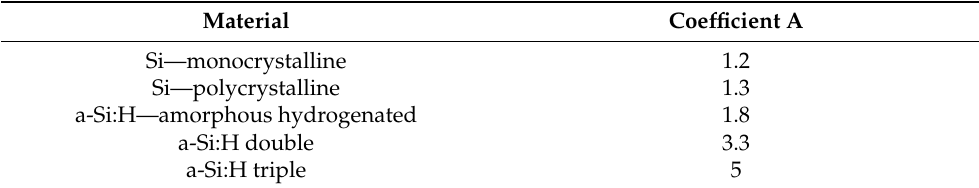
Table 1. Ideality factor of the solar cell from material